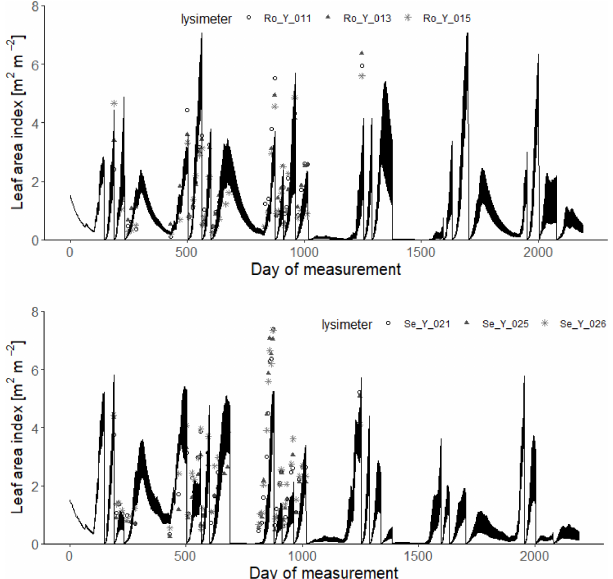
Figure 10. Measured harvests of above-ground biomass (symbols; 2013–2018) compared with simulations at each site (black symbols indicate means of the 30 acceptable parameterizations, and the ver- tical lines denote minimum and maximum values). Day 1 is 1 Jan- uary